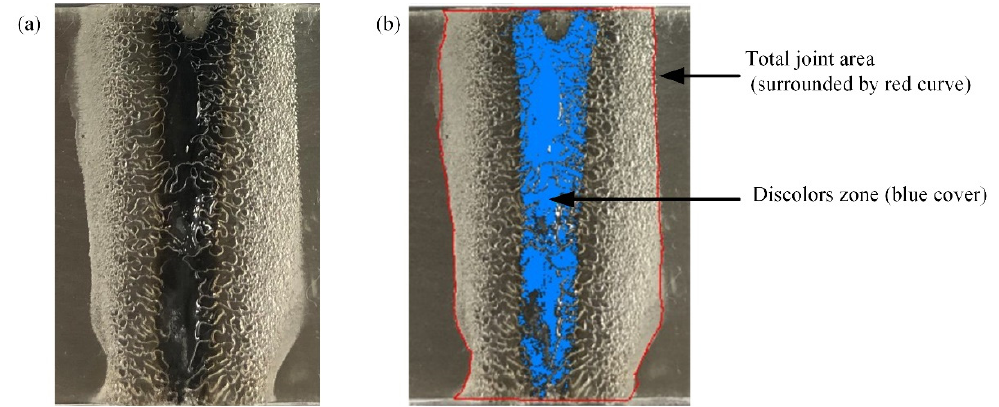
Figure 11. Example of joint NO.11 to display the ImageJ measurement in the discolored zone: ( a ) image of joint NO.11 before the ImageJ analysis and ( b ) image of joint NO.11 after the ImageJ analysis.